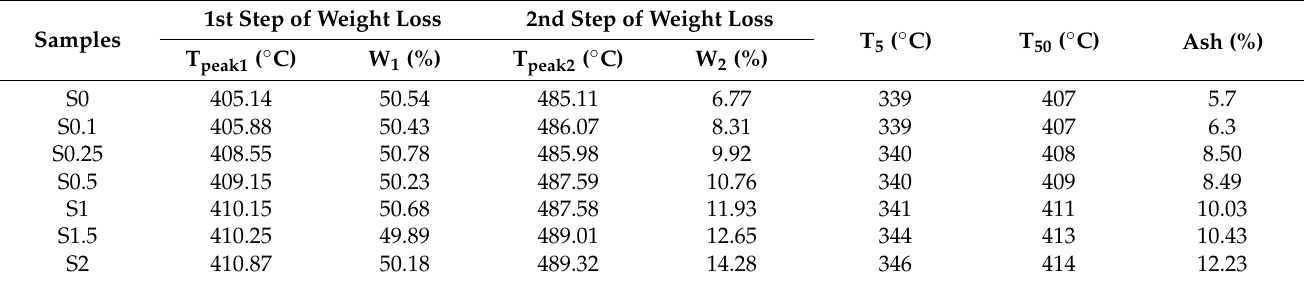
Table 3. Thermal degradation characteristics of the NR/CNT/GNS Foam.